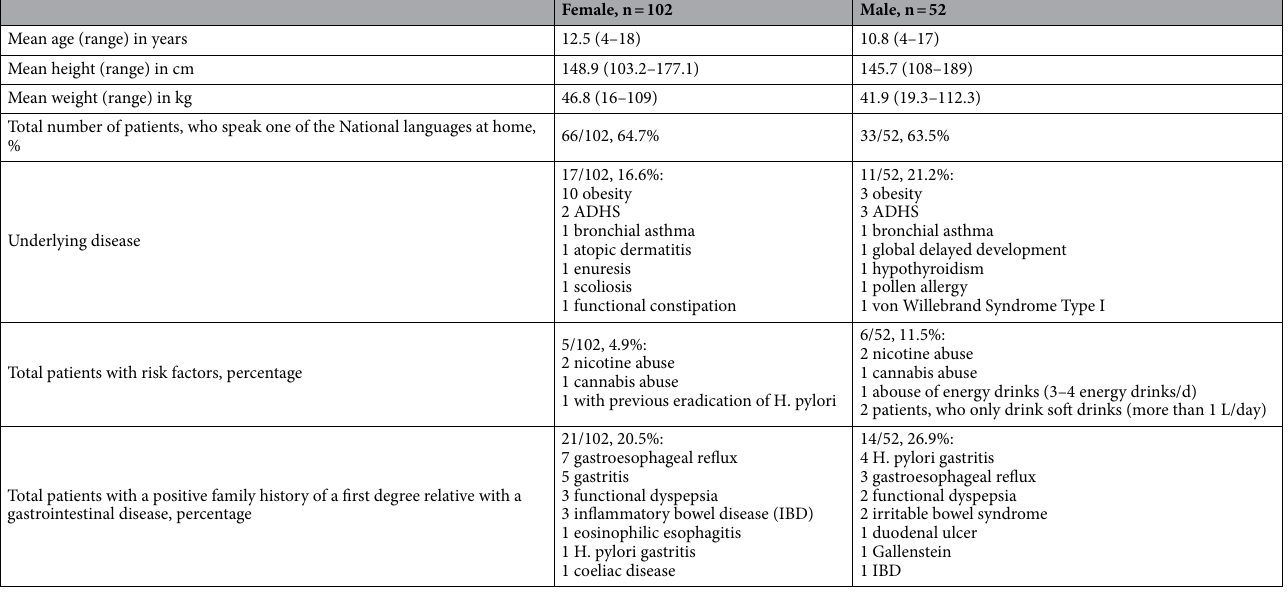
Table 1. Patient’s characteristics.